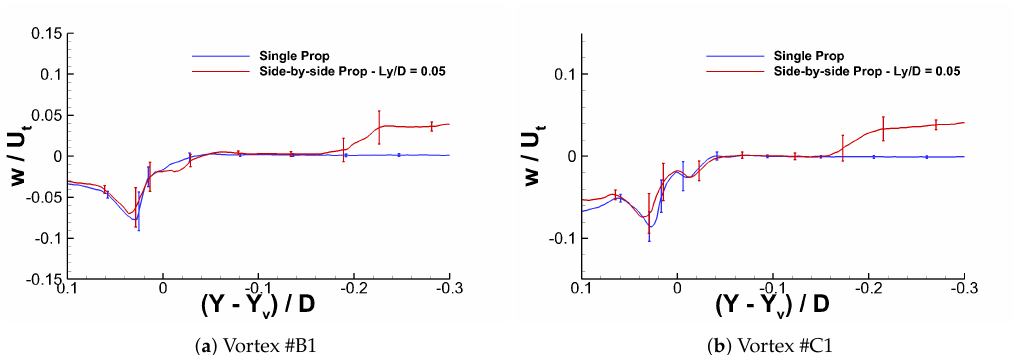
Figure 14. Comparison of the phase-averaged non-dimensional out-of-plane velocity component profiles w extracted in correspondence with the tip vortices core locations ( X v , Y v ) for blade azimuthal angle ψ = 90 ◦ for advance ratio J = 0.4 , Re D = 1.96 × 10 6 , and M t = 0.325.